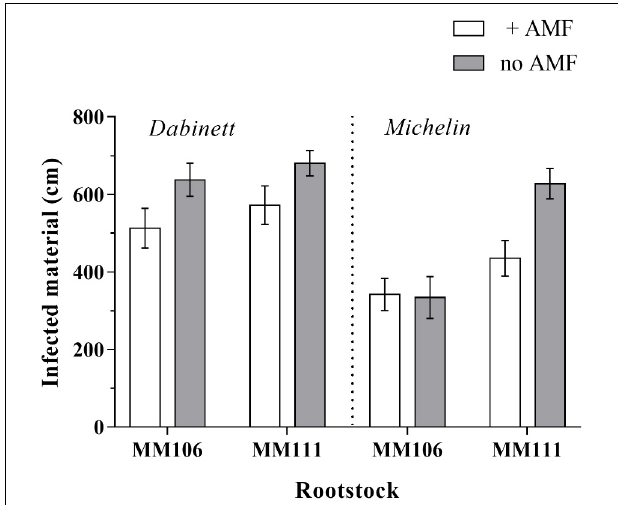
FIGURE 3 | Total apple tree ( Malus pumila ) material infected by the fungal pathogen Neonectria ditissima . Trees were grown with and without inoculation with arbuscular mycorrhizal fungi (AMF). Error bars represent ± SE per treatment ( n = 20). Total pathogen infected material was significantly affected by AMF inoculation ( P = 0.001), scion type ( P < 0.001) and rootstock type ( P <